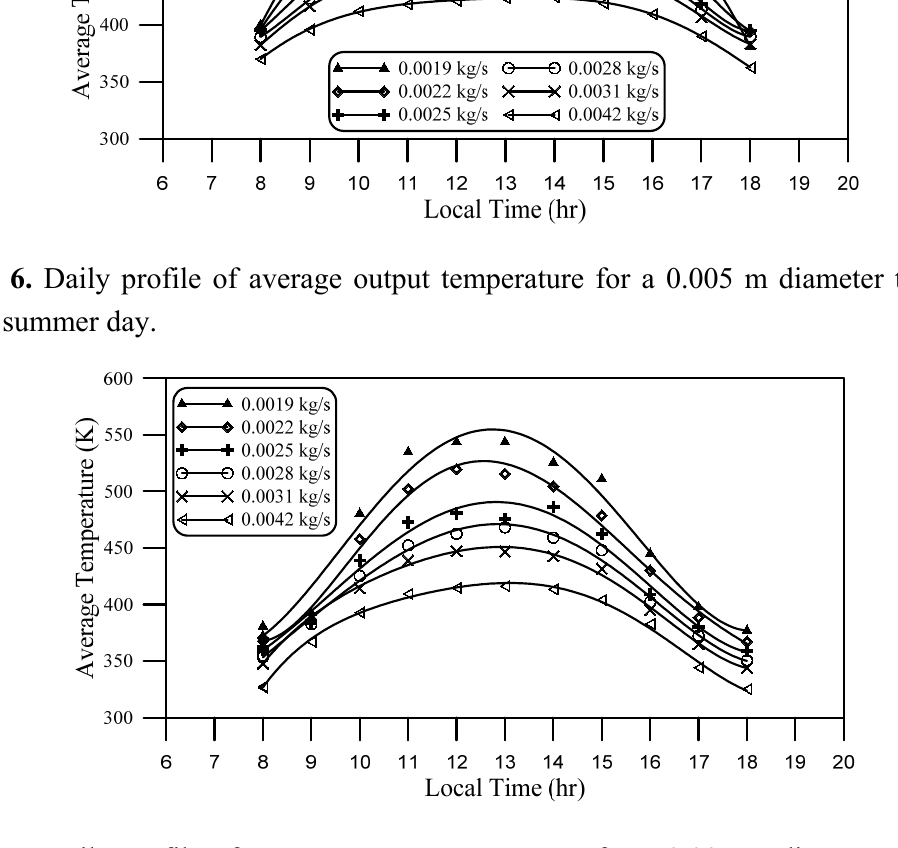
Figure 7. Daily profile of average output temperature for a 0.005 m diameter tube on a typical winter